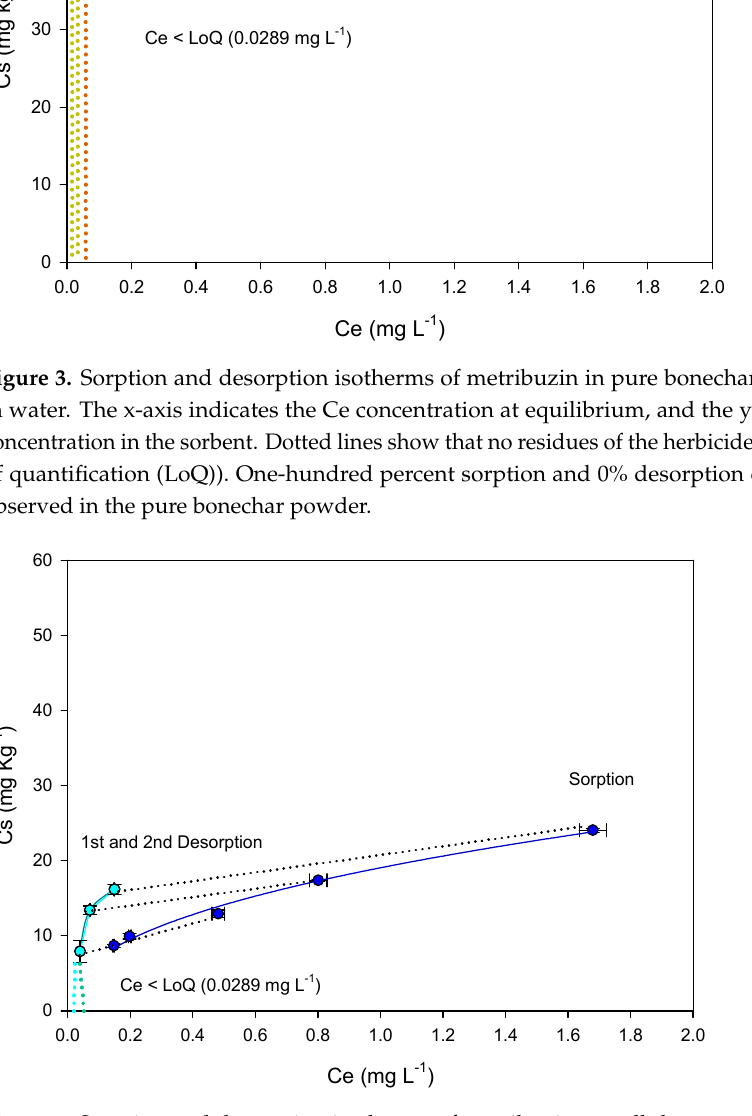
Figure 3. Sorption and desorption isotherms of metribuzin in pure bonechar powder (2 g) added in water. The x ‐ axis indicates the Ce concentration at equilibrium, and the y ‐ axis indicates the Cs concentration in the sorbent. Dotted lines show that no residues of the herbicide were detected (<limit of quantification (LoQ)). One ‐ hundred percent sorption and 0% desorption of the herbicide were observed in the pure bonechar powder.